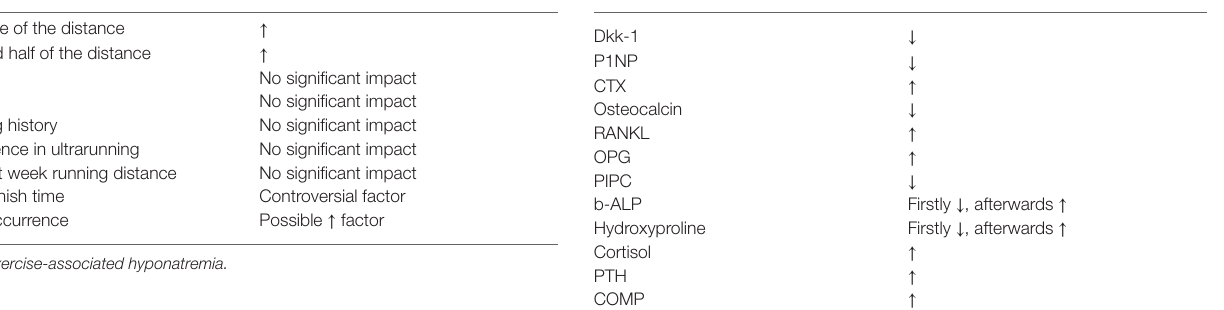
TABLE 3 | Bone and cartilage markers after an ultramarathon. TABLE 2 | Factors affecting CK increase after an